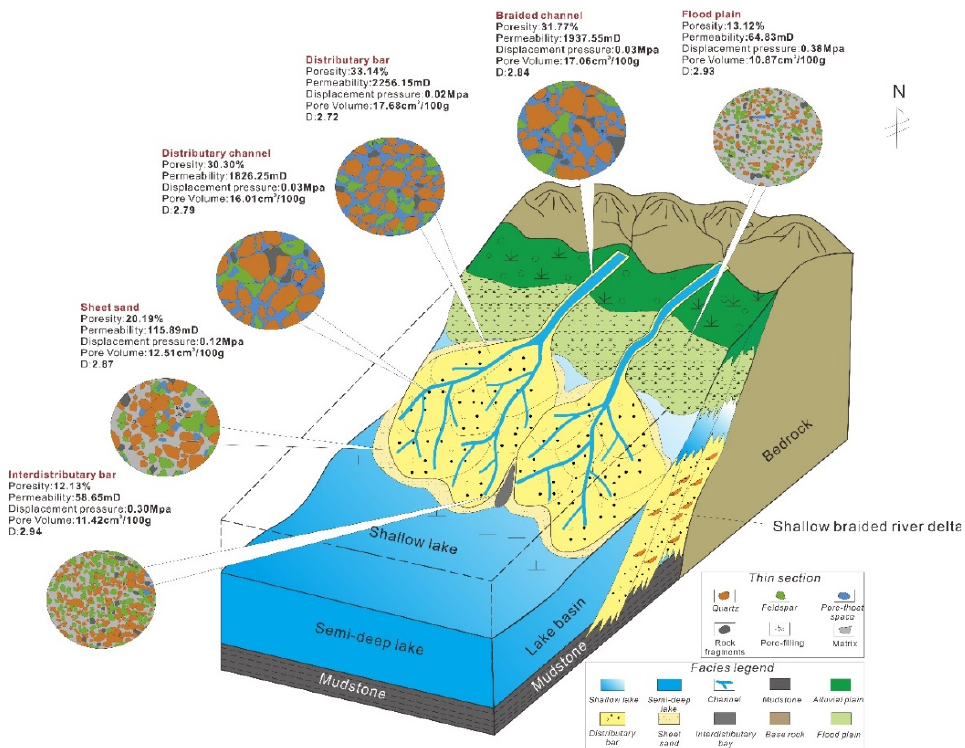
Figure 19. A summary diagram that displays pore characteristics controlled by microfacies in a deltaic depositional environment.